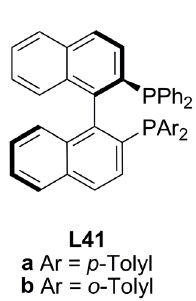
Figure 17. BINAPP’